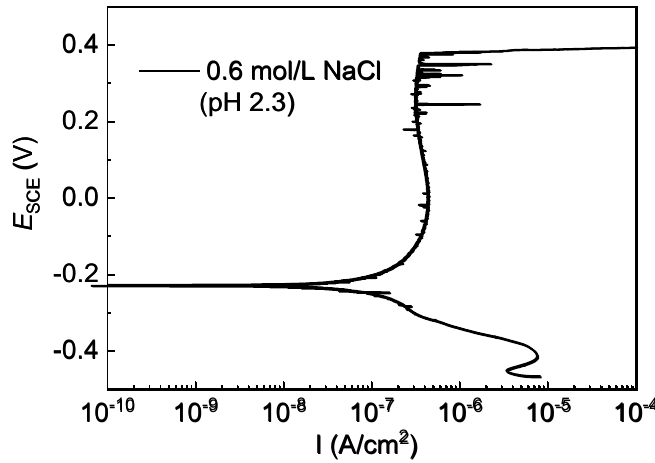
Figure 8. Potentiodynamic polarization curves of 304 SS in 0.6 mol/L NaCl solution (pH 2.3). Table 5. The parameters from the polarization curves of 304 SS in 0.6 mol/L NaCl solutions.